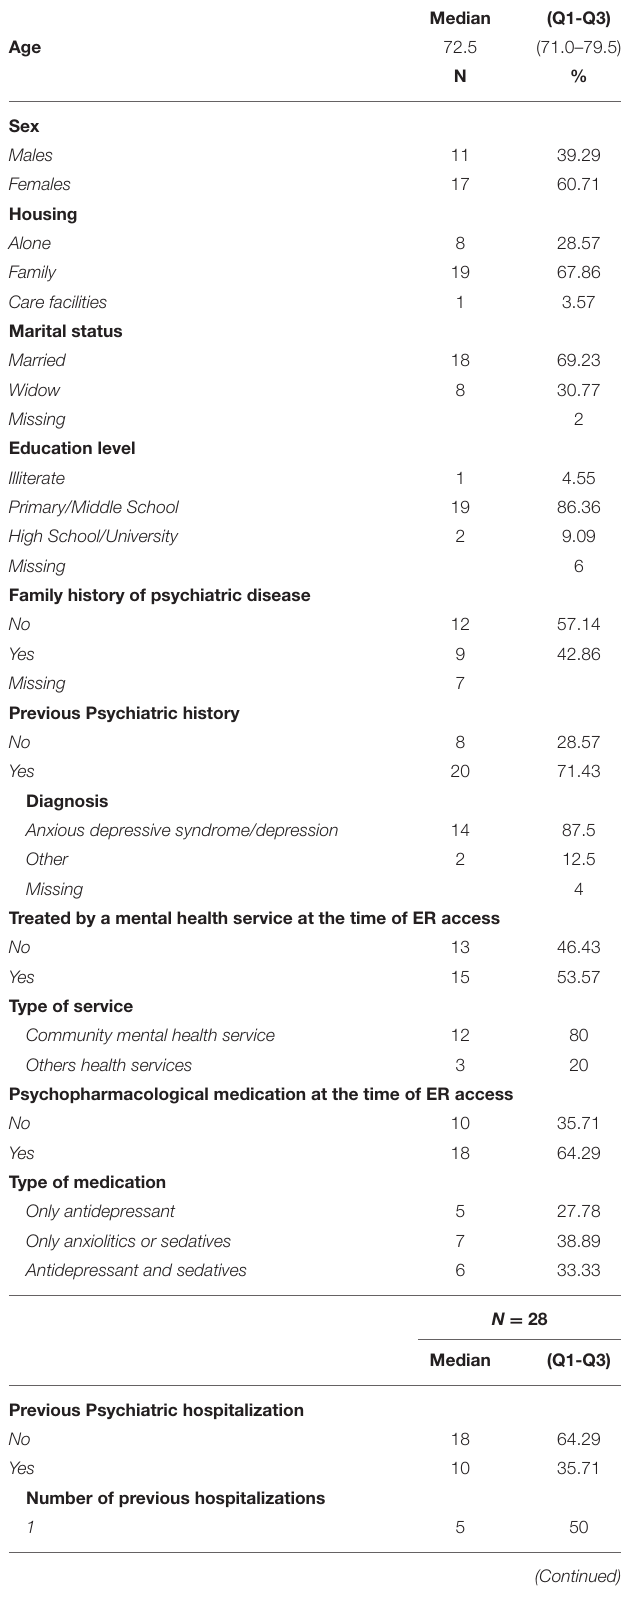
TABLE 1 | Sociodemographic, hospitalization, and discharge features for the whole sample ( N =